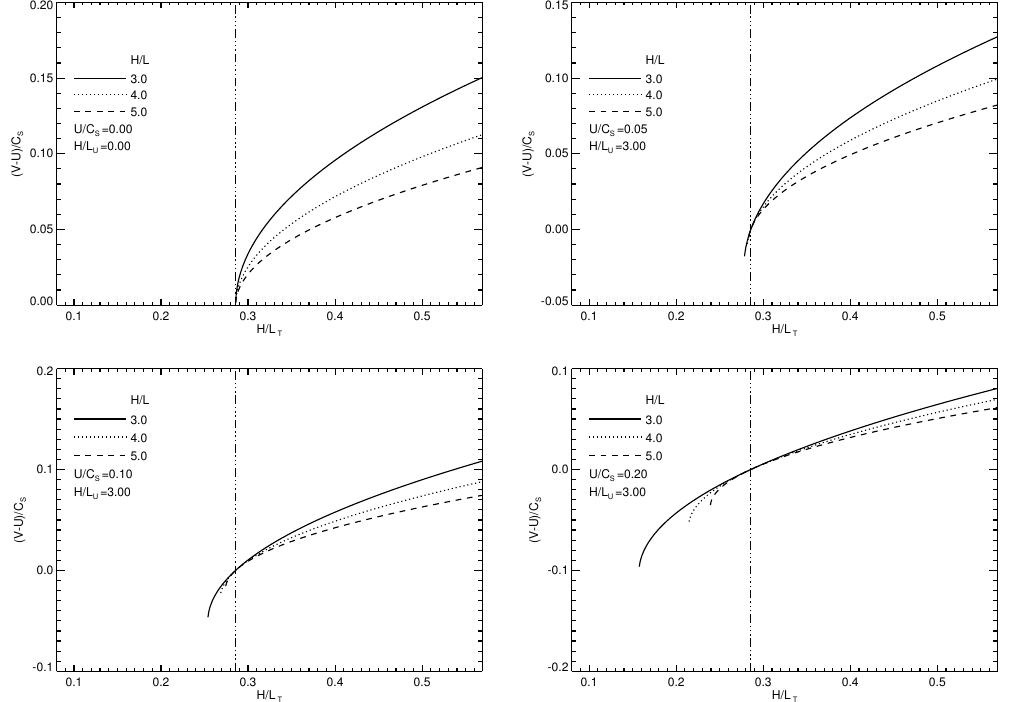
Fig. 1. The roll normalized velocity (v − U)/c S as a function of the dimensionless parameters H/L , H/L T , normalized wind velocity U/c s and the characteristic spatial scale of the wind shear H/L U .